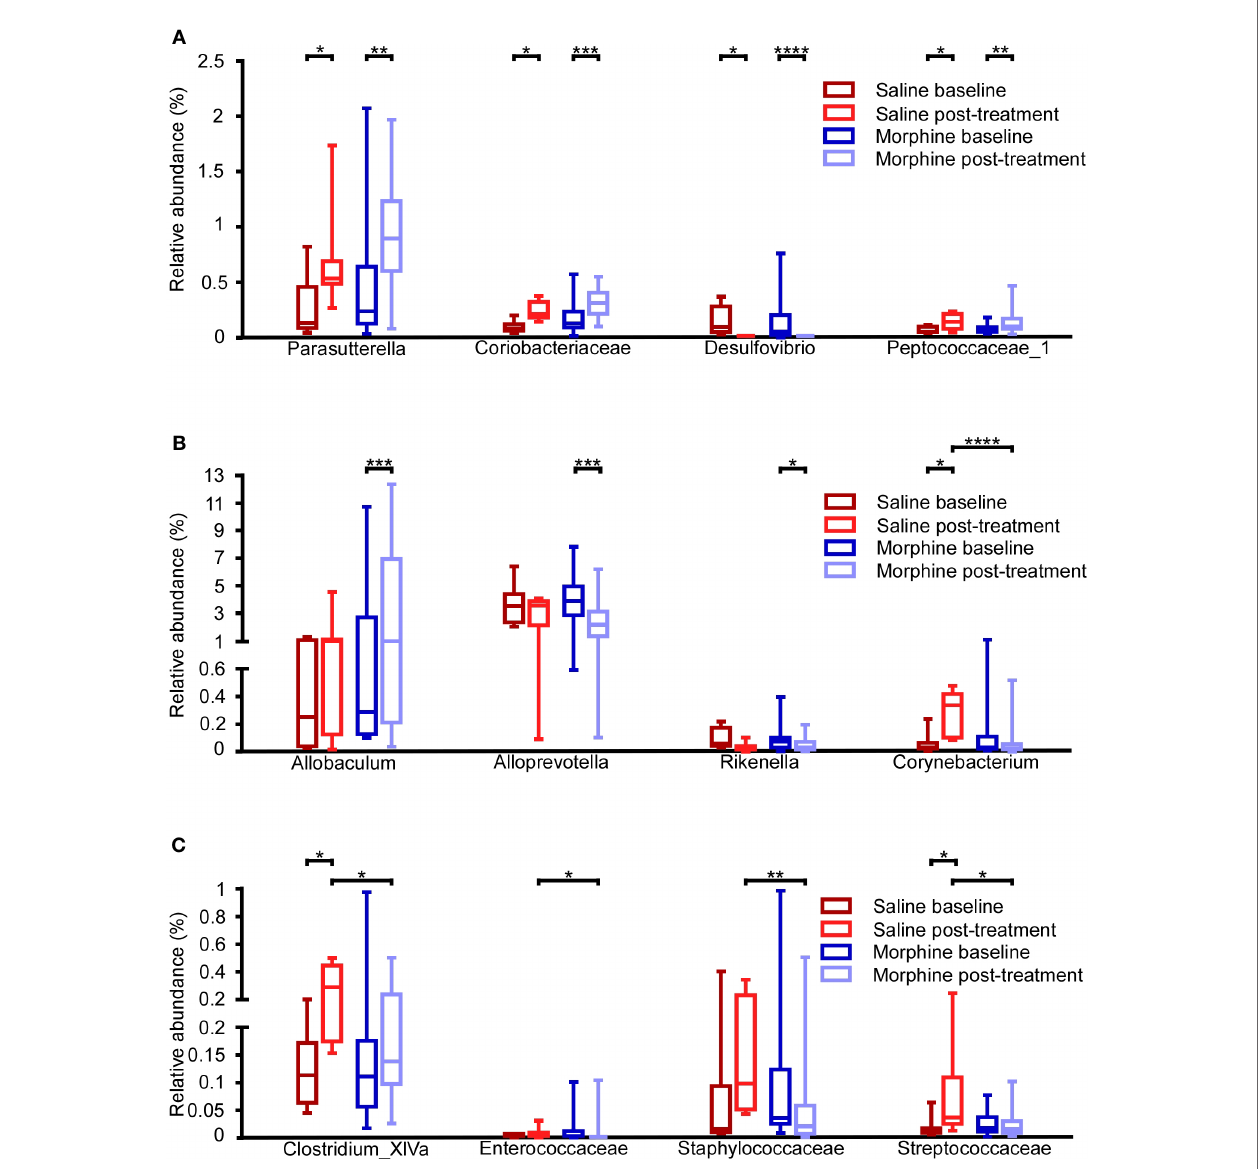
FIGURE 4 | Comparison of the gut microbiota composition among the baseline and post-treatment for the morphine and saline group. Comparison of the relative abundance of gut microbiota at the family and genus levels among the saline-baseline, saline post-treatment, morphine-baseline and morphine post-treatment groups. (A) The relative abundance of Parasutterella , Coriobacteriaceae , Desulfovibrio and Peptococcaceae_1 were shown. (B) The relative abundance of Allobaculum , Alloprevotella , Rikenella and Corynebacterium were shown. (C) The relative abundance of Clostridium_XlVa , Enterococcaceae , Staphylococcaceae and Streptococcaceae were shown. A Mann-Whitney test and Wilcoxon signed rank test were used to analyze the data. A student ’ s t test was used for the data with Gaussian distribution. The central line shown in each box plot indicates the median of data. Whiskers extend to cover the whole range of values.Statistical signi fi cance was accepted at p < 0.05. *p < 0.05; **p < 0.01; ***p < 0.001; ****p <